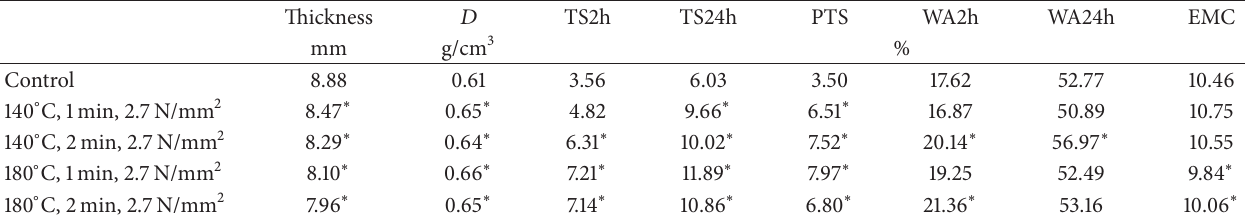
Table 2: Physical properties of plywood made from thermomechanically treated veneers.